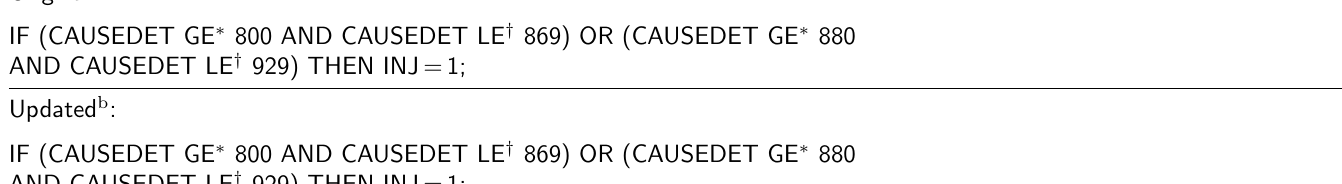
Table 2: Altered external cause of injury morbidity matrix SAS